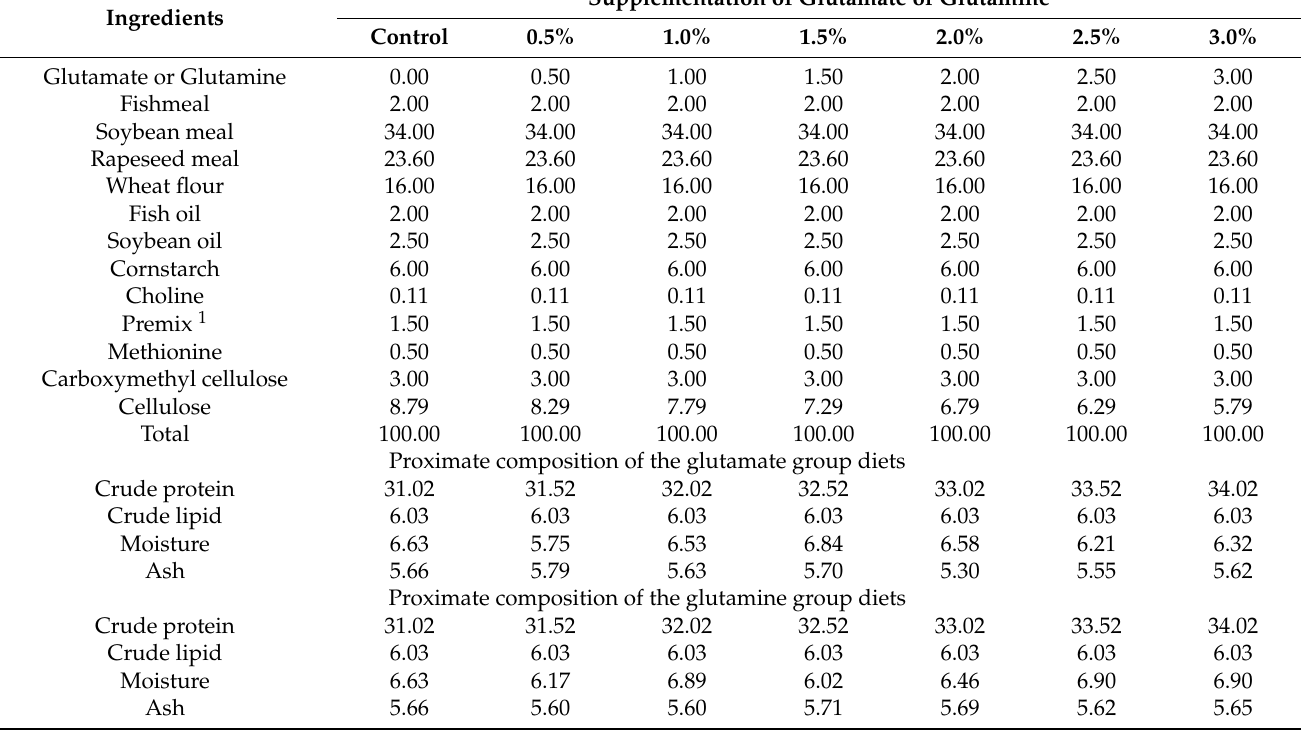
Table 2. Diet formulation and chemical composition of the glutamate diets or glutamine diets (% dry